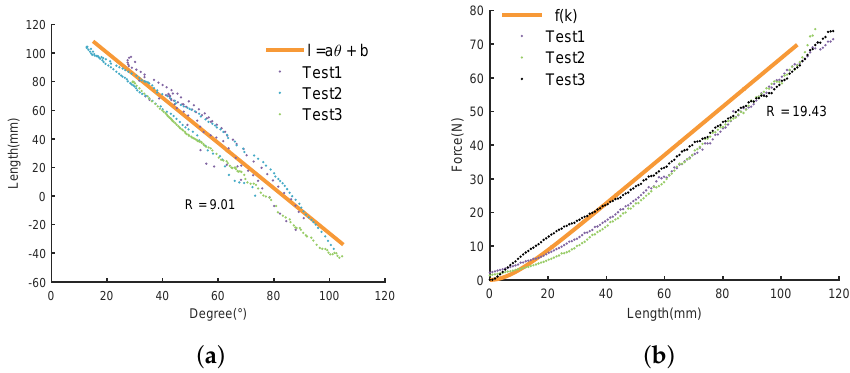
Figure 8. Experimental results of model validation, where R is the root mean square error (RMSE). ( a ) is the result of model (1), where l is the length of Bowden Cable. ( b ) is the result of model (2), where f is the output